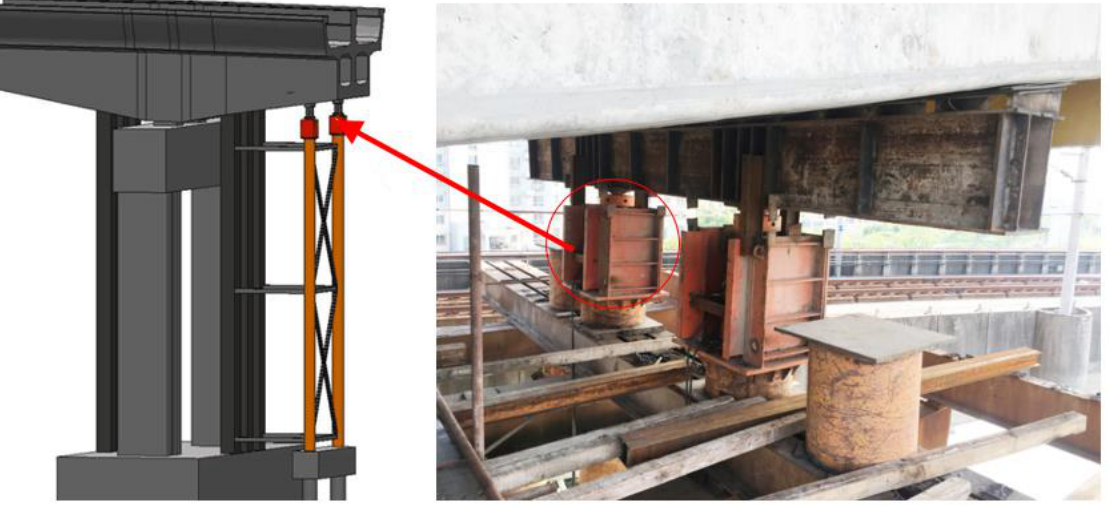
Figure 4. The axial force servo system.